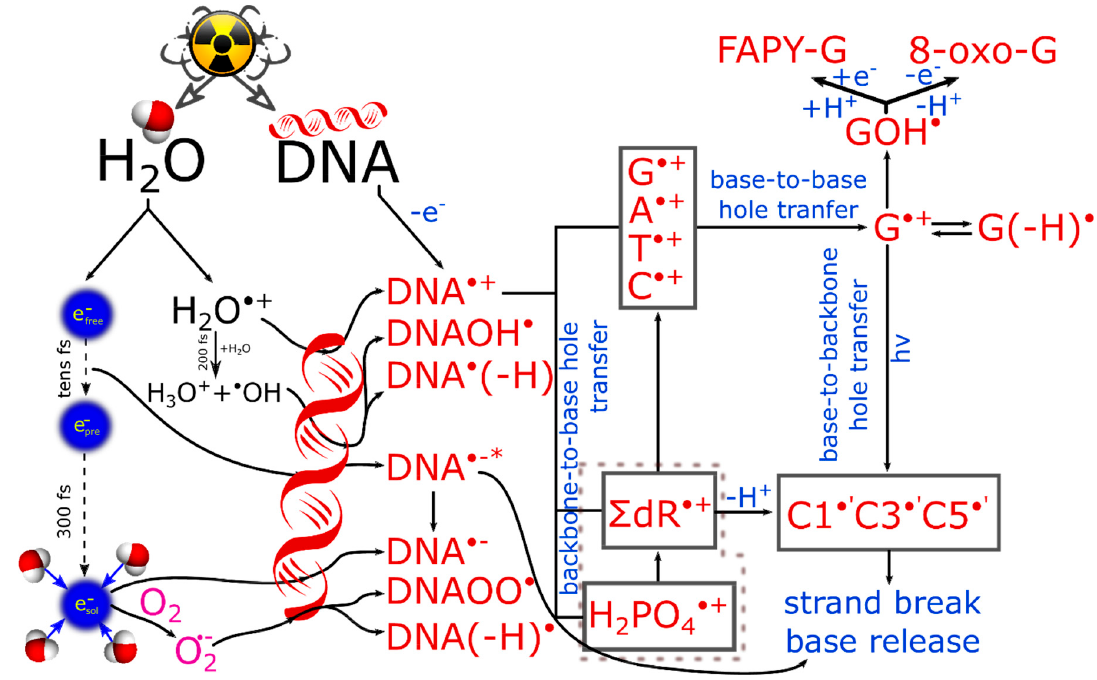
phosphate radicals (PO 3•2 − (E 0 /V (standard electrode potential, PO 3•2 − + H + + e – = HPO 32 − ) = 1.54), H 2 PO 4• (E 0 /V = 2.75 [84]) have been shown to be strong one-electron oxidants. In addition, laser flash photolysis studies of a ribose-5-phosphate solution at room temperature have provided evidence